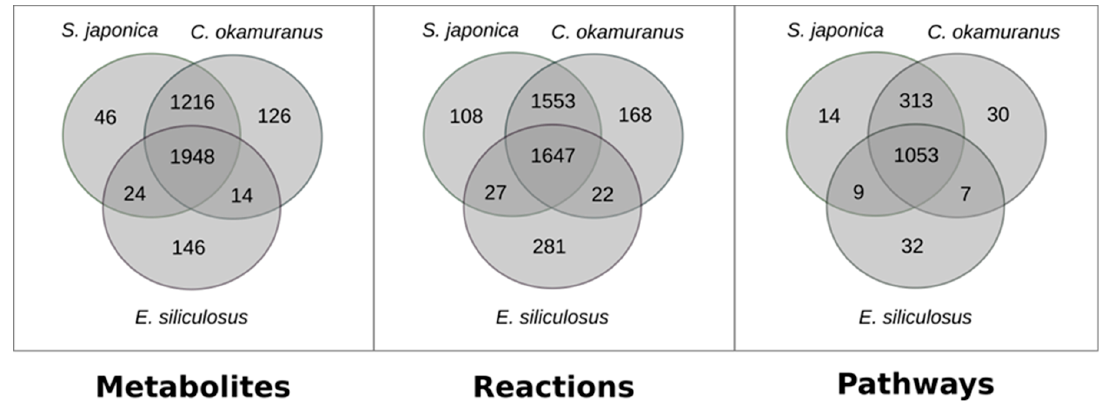
Figure 1. Comparison of the content of genome – scale metabolic networks of the three brown algae S. japonica , C. okamuranus, and E. siliculosus.